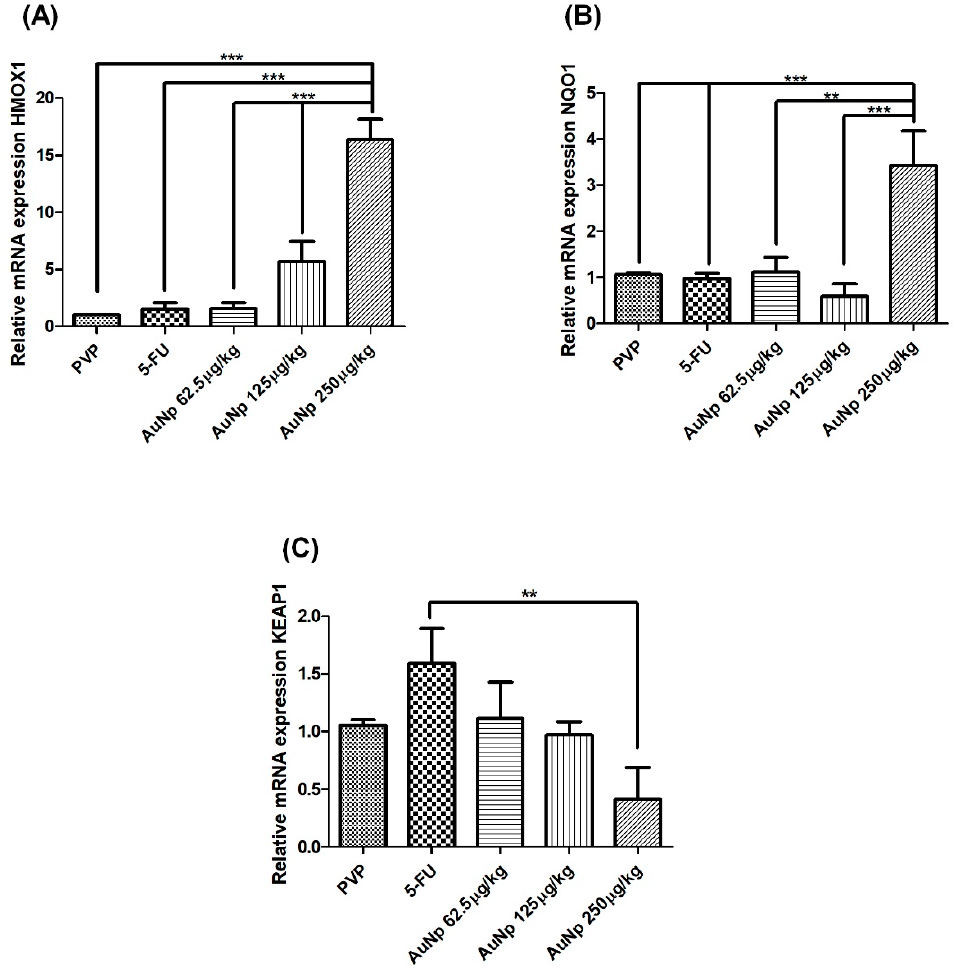
Figure 7. Real-time PCR for heme oxigenasse 1 (HMOX-1) ( A ); NAD(P)H quinone dehydrogenase 1 (NQO1) ( B ); and Kelch-like ECH-associated protein 1 (KEAP1) ( C ). The group AuNp 250 µ g / kg increased the expression of the HMOX1 or NAD(P)H genes compared to the 5-FU group. The AuNp 250 µ g / kg decreased the KEAP1 mRNA expression compared to 5-FU animals. The results are presented as the mean ± standard error of the mean, ( n = 5/group). * p < 0.05; ** p < 0.001; *** p < 0.0001 (analysis of variance with Tukey’s post-test).